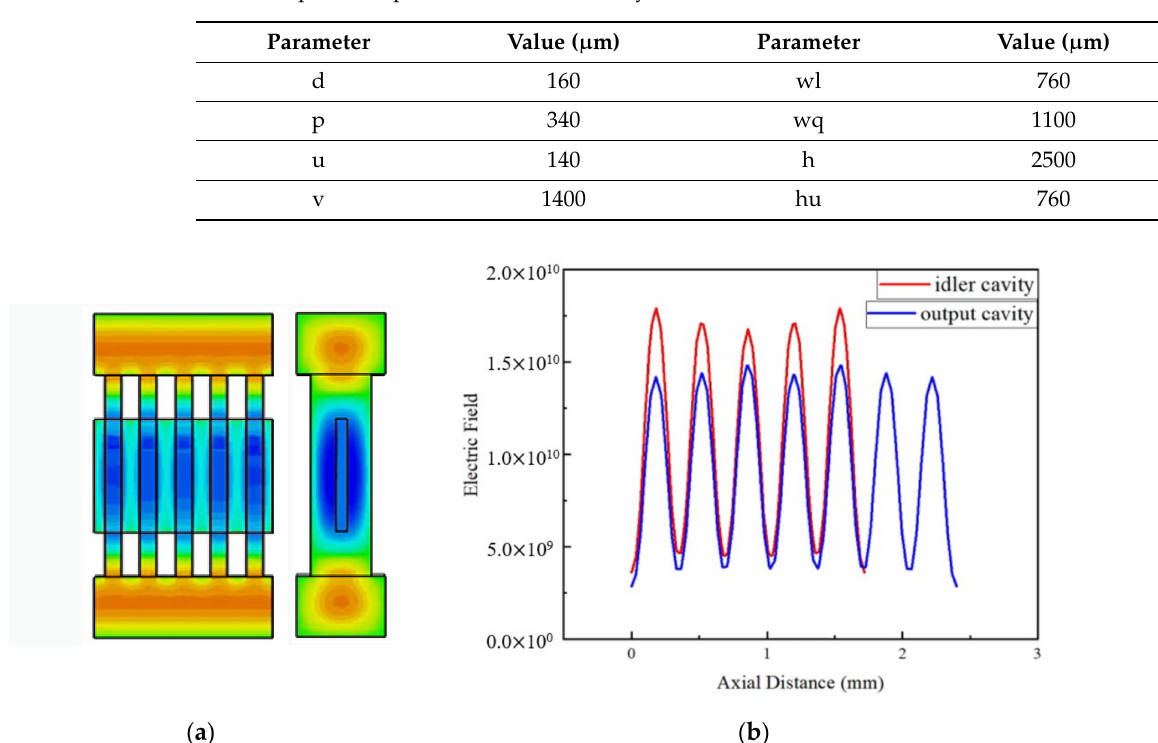
Table 1. Optimized parameters of idler cavity.